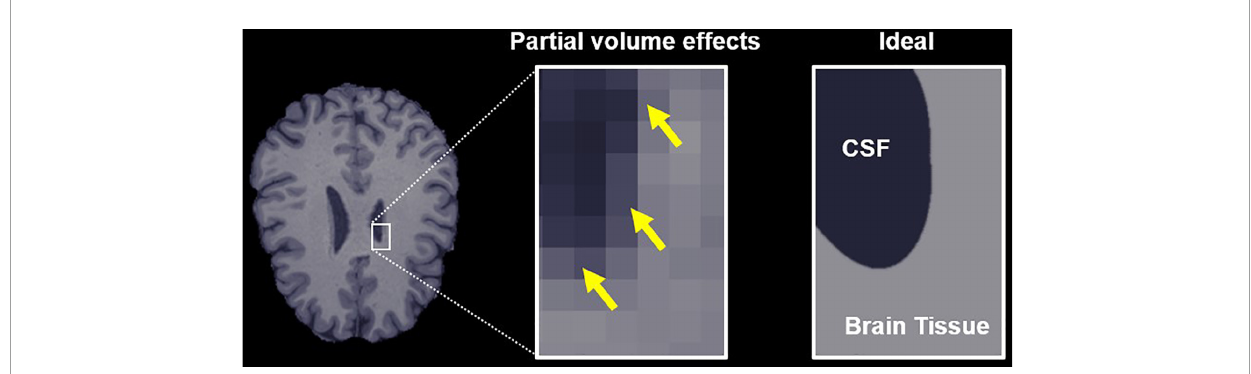
FIGURE1 Free water partial volume effects at the interface between brain tissue and a ventricle containing cerebrospinal fluid (CSF). The image on the right depicts an ideal slice in which the brain tissue and CSF are clearly delineated, while the center image depicts partial volume effects in voxels that contain both CSF and tissue, highlighted by yellow arrows. The goal of the proposed algorithm is to obtain parameter estimates specific to the tissue in these